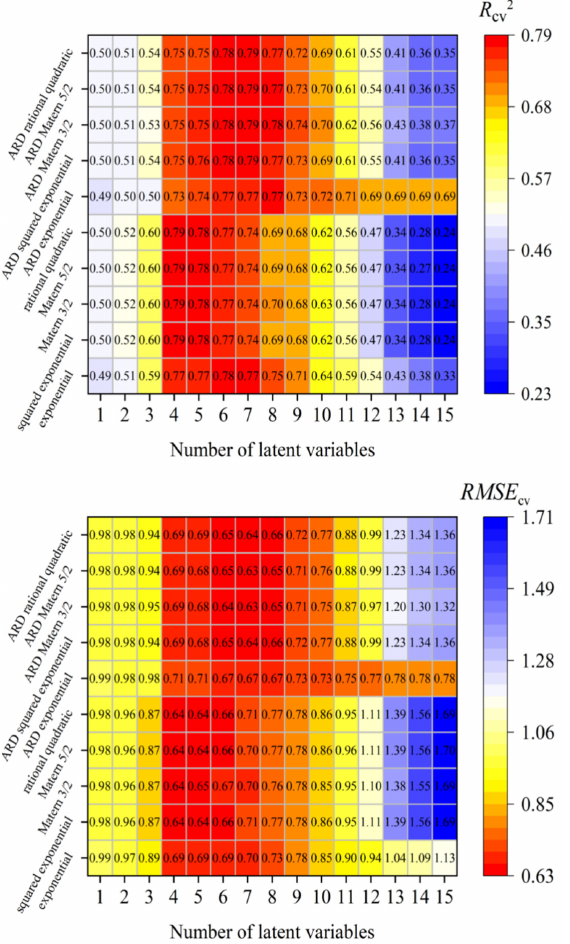
2 cv ( top ) and RMSE cv ( bottom